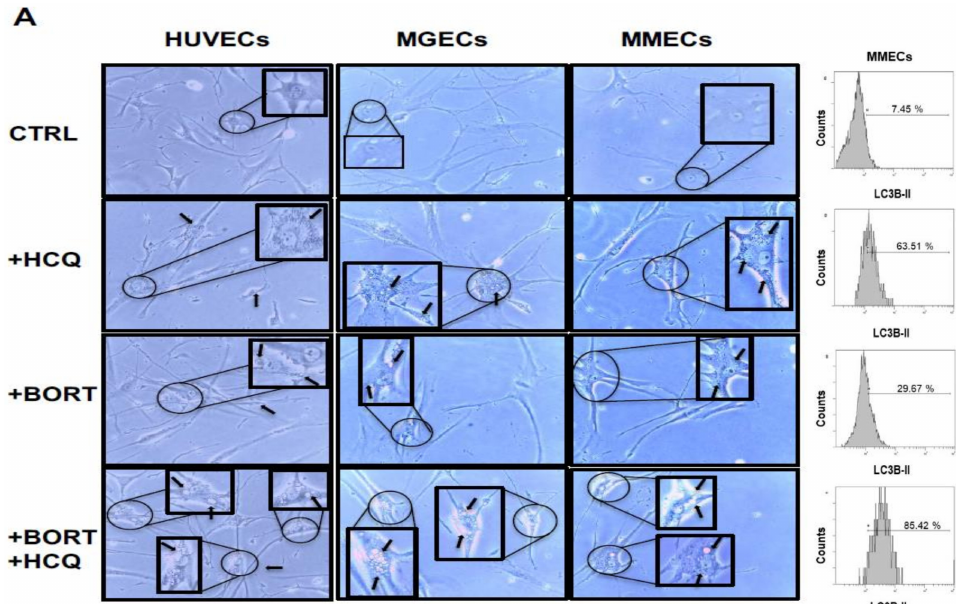
Figure 5. Bortezomib and hydroxychloroquine combination increases autophagosome number in ECs. ( A ) HUVECs, MGECs ( n = 4), and MMECs ( n = 4) were treated with HCQ (100 uM), bortezomib (10 nM), or both drugs. Representative photomicrographs (on the left) and flow cytometry plots (on the right) of four independent experiments are shown. Black arrows indicate autophagosome vacuoles (magnification 20 × ).